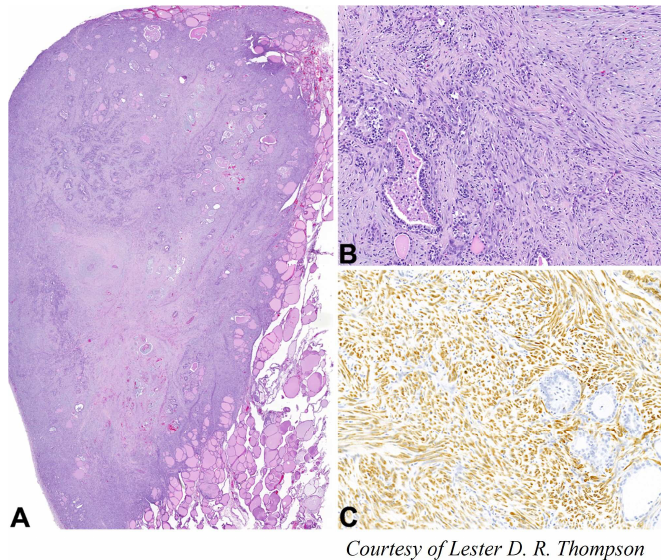
Figure 7. ( A ) Large destructive leiomyosarcoma within the thyroid gland (×200 magnification). ( B ) The neoplastic cells are spindled, showing an interlacing fascicular architecture (×100 magnifica- tion). ( C ) The neoplastic cells show a strong and diffuse cytoplasmic reaction with smooth muscle actin (×100 magnification).